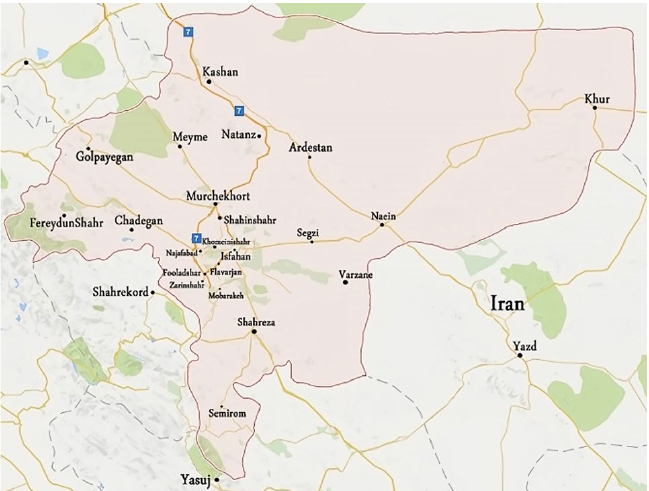
Figure 7. Locations of O–Ds in Isfahan’s intercity road